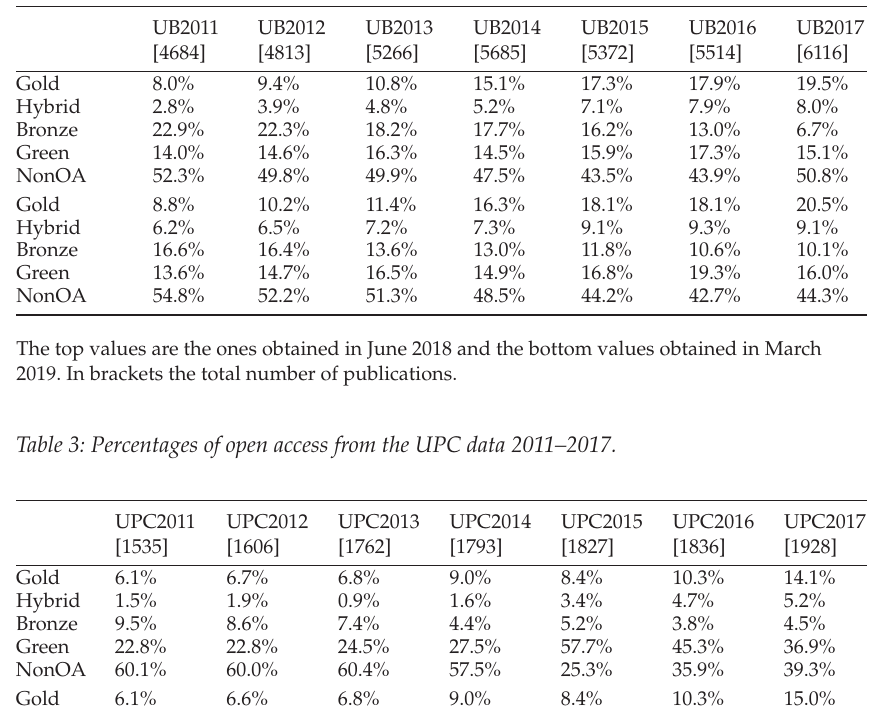
Table 2: Percentages of open access from the UB data 2011–2017.